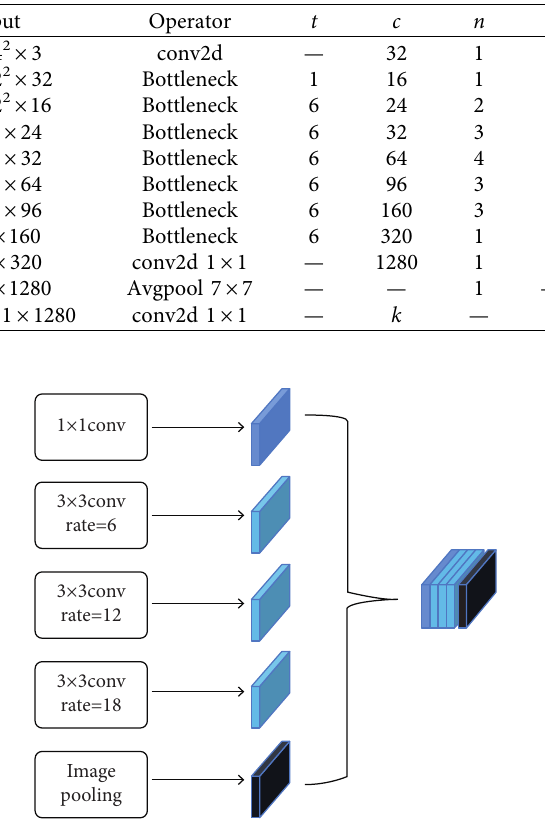
Figure 1: ASPP model structure